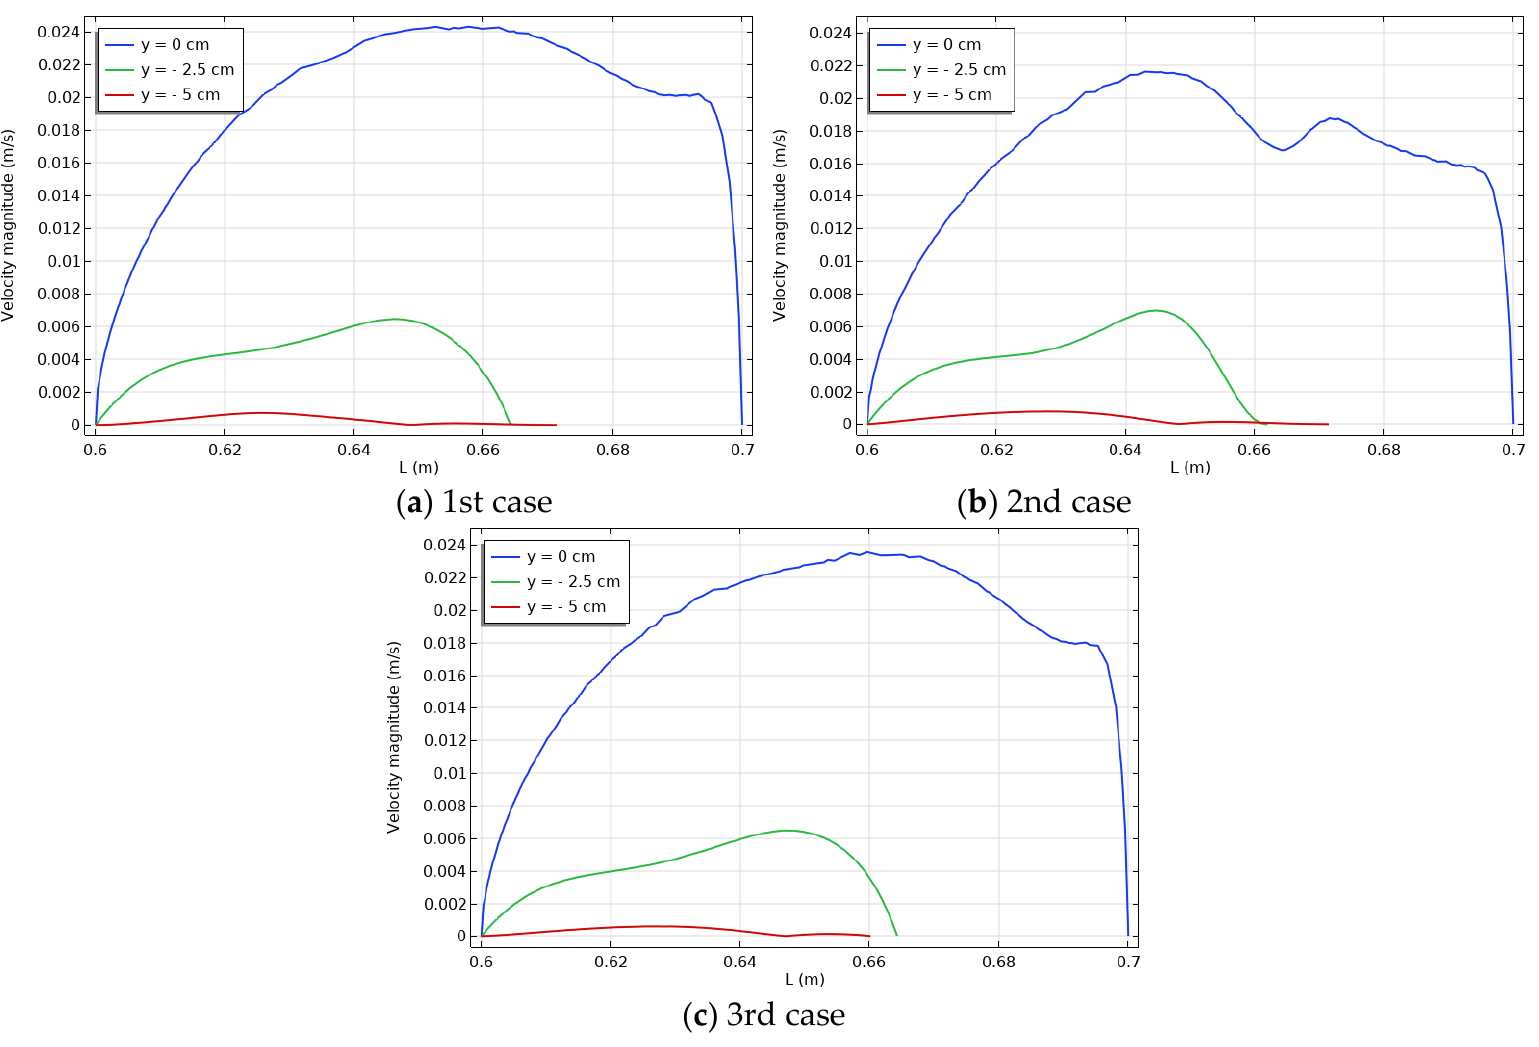
Figure 10 . Velocity distribution during the negative y axis in the cavity . Figure 10. Velocity distribution during the negative y axis in the